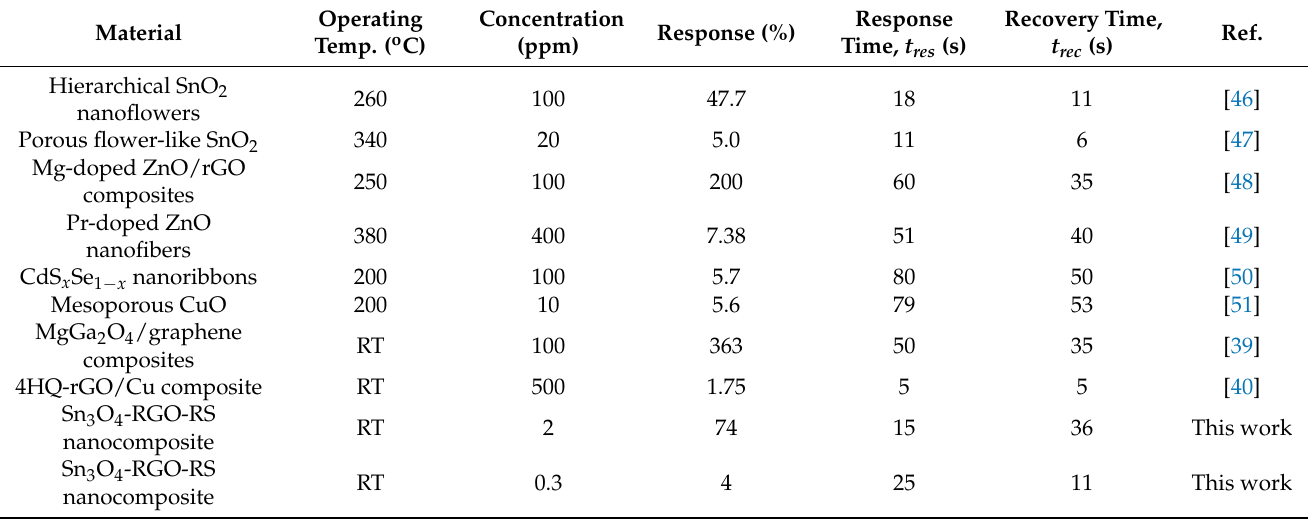
Table 4. Summary of CH 3 COOH sensors is based on different sensing materials reported in the literature and this work.